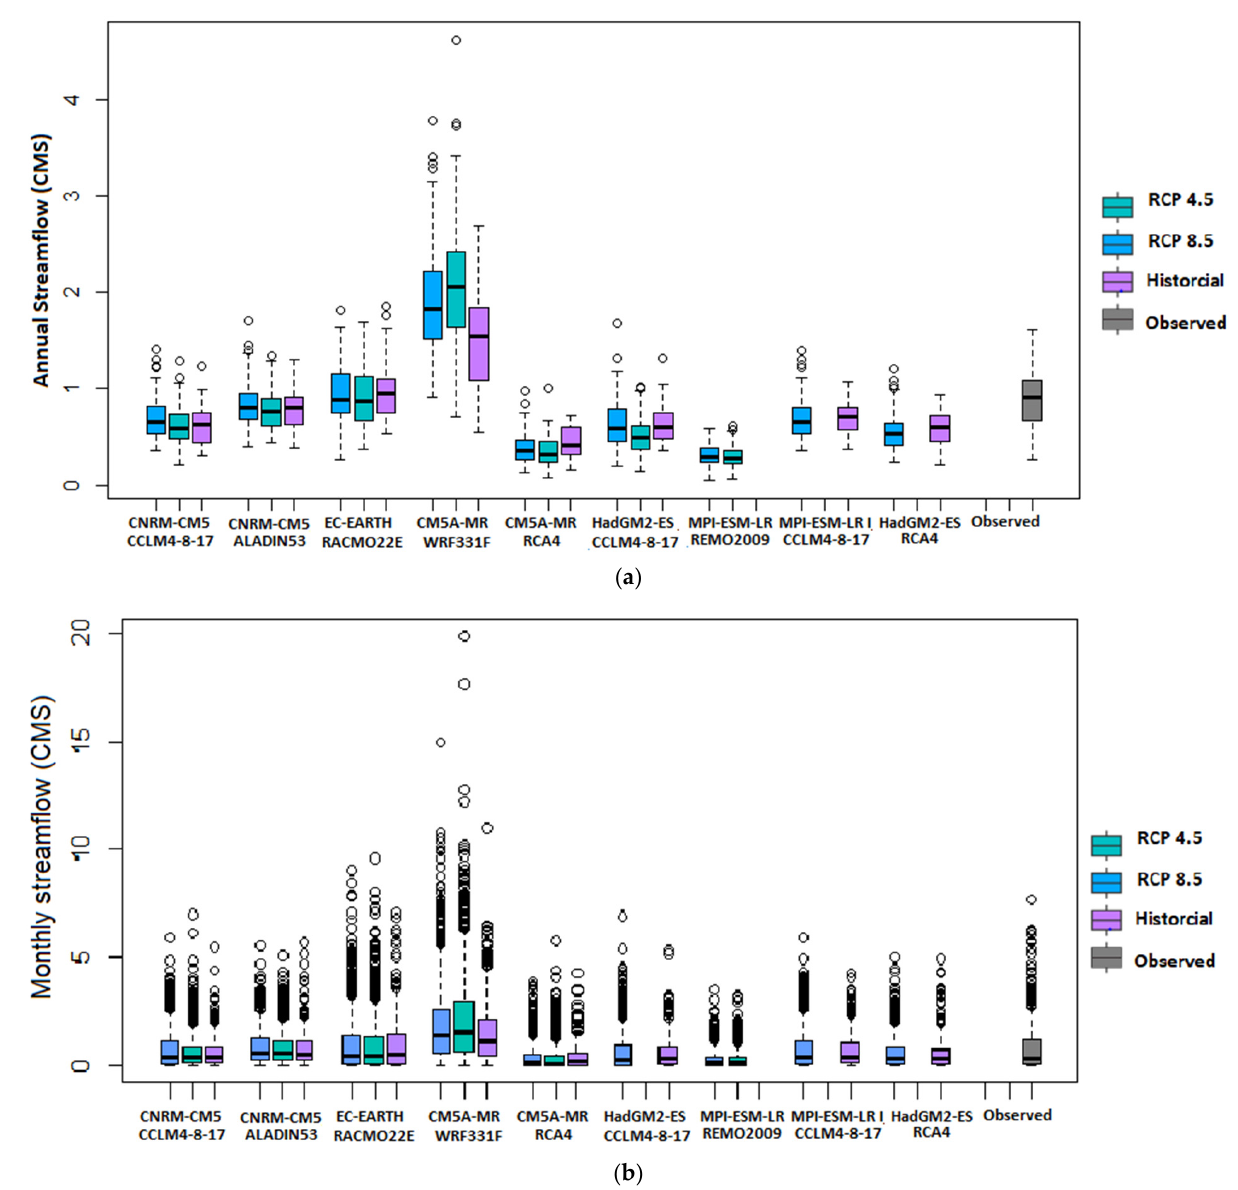
Figure 11. Box-and-whiskers plots for monthly ( b ) and annual ( a ) streamflow of Tsiknias River for each RCM/GCM combination. The central line is the median, while whiskers represent 25th and 75th percentiles.